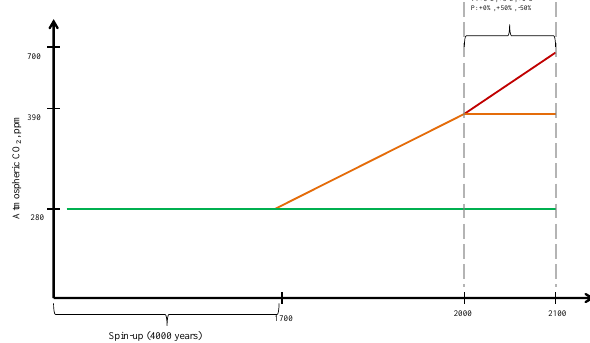
Fig. 1. Structure of the model run.